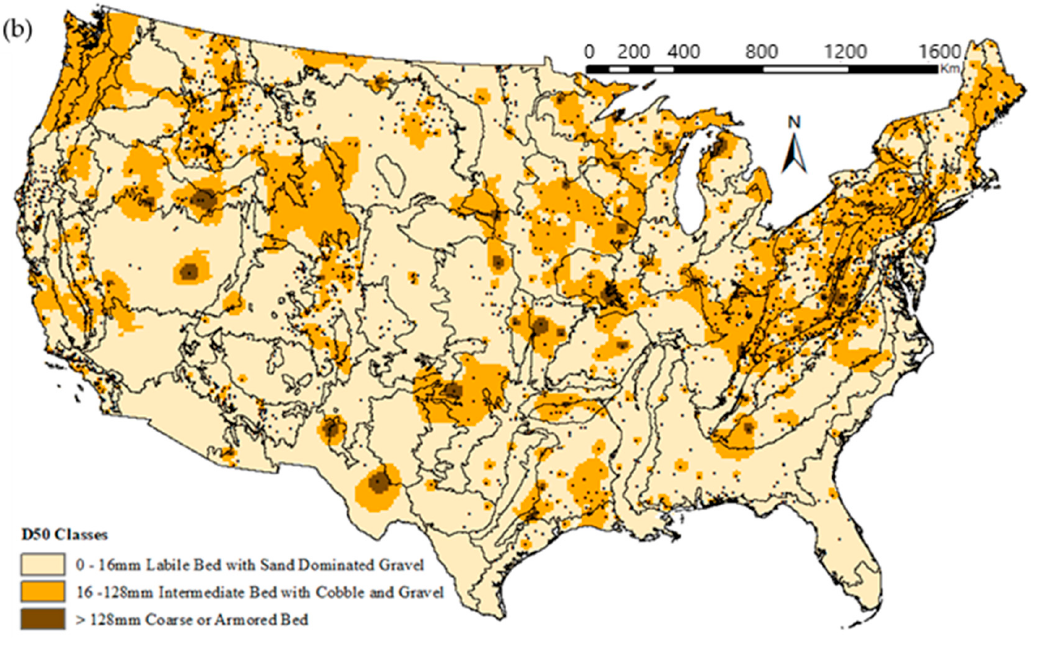
Figure 12. Map of interpolated D50 over the Contiguous U.S. with three streambed classes ( a ) overlaid with a map of physiographic provinces ( b ) overlaid with a map of level III Ecoregions. The black dots on the map show the locations of D50 data points.